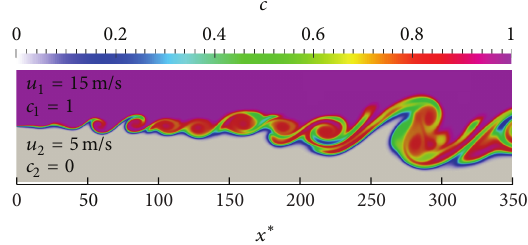
Figure 1: Schematic view of the mixing layer, with instantaneous fiber concentration 𝑐 in the mixing layer for the case Sc = 1